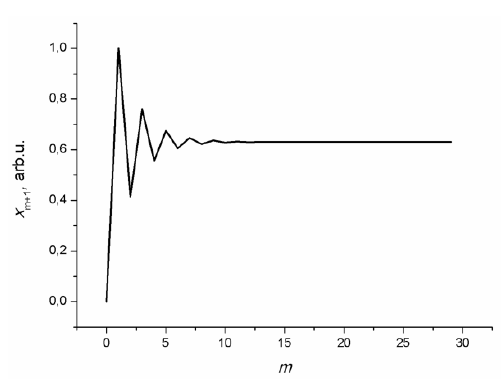
Fig. 2. Plot of the dependence of the function 1 + m x on m (number of generations), that characterizes the kind of cycles S occurring in the dynamic linguistic system: in the PC linguistic community, chaos begins to arise.